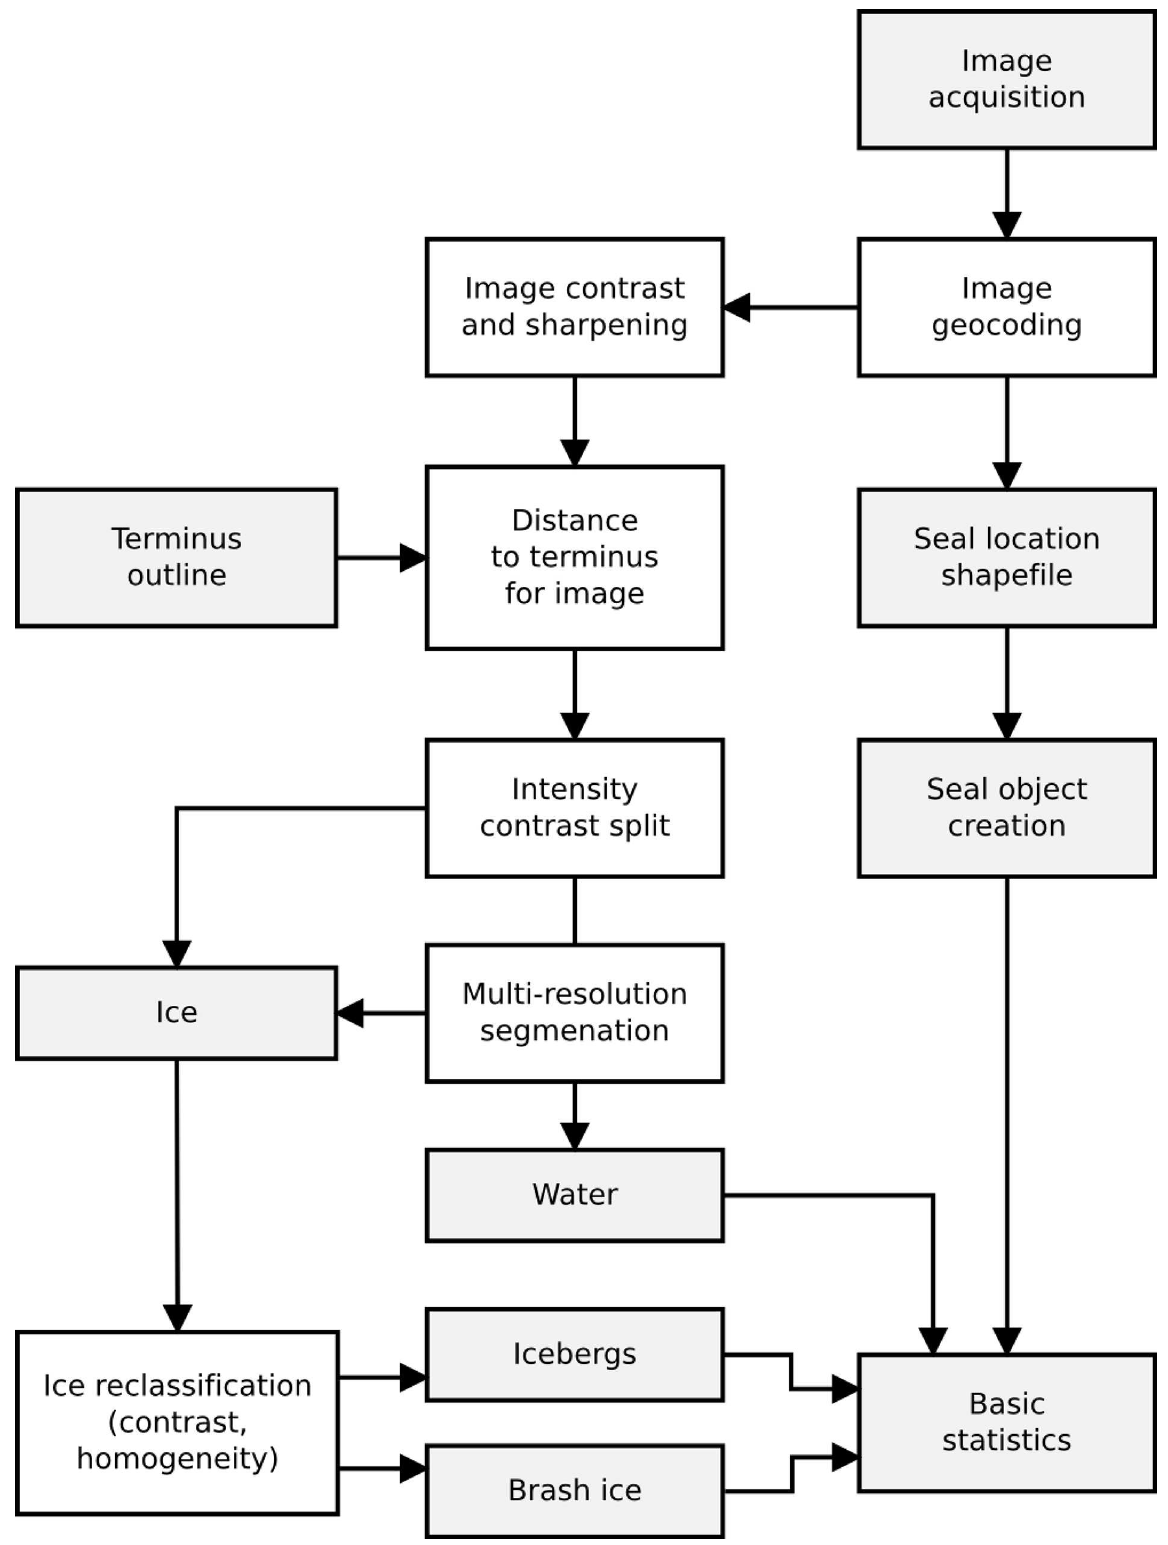
Fig 2. Workflow from aerial image acquisition to generation of distribution maps and statistics for seals and